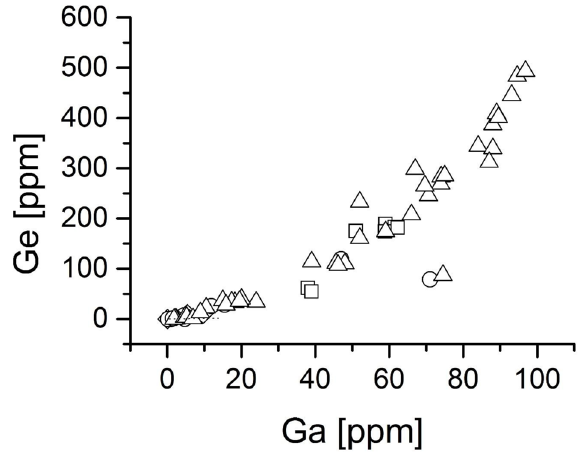
Figure 4. Linear plot Ge against Ga for iron meteorites without plessitic octahedrite Butler (data from Table 2). r = 0.91, Δ octahedrites, o hexahedites, ¡ ataxites, ◊